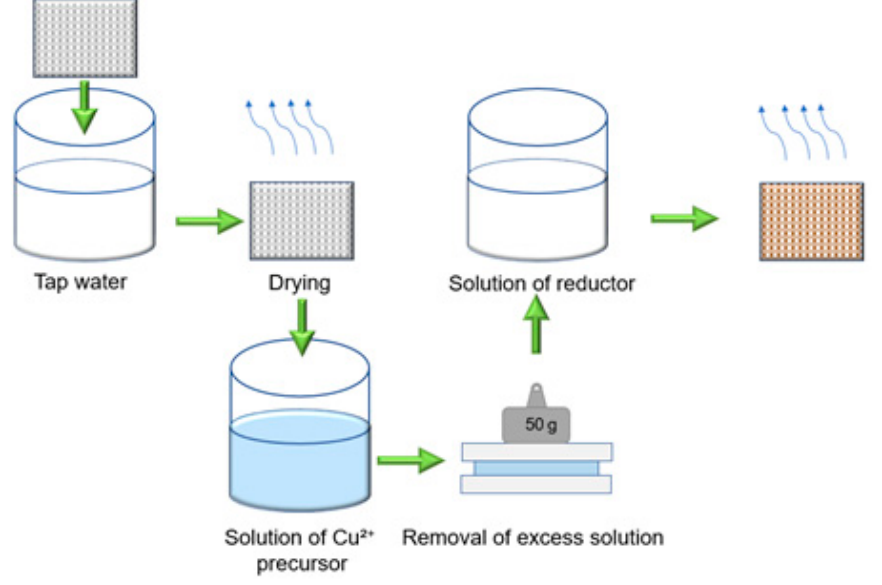
Figure 1. Scheme for the synthesis of copper particles in textile materials. Table 2. Conditions for saturation of textile materials with copper-containing particles.